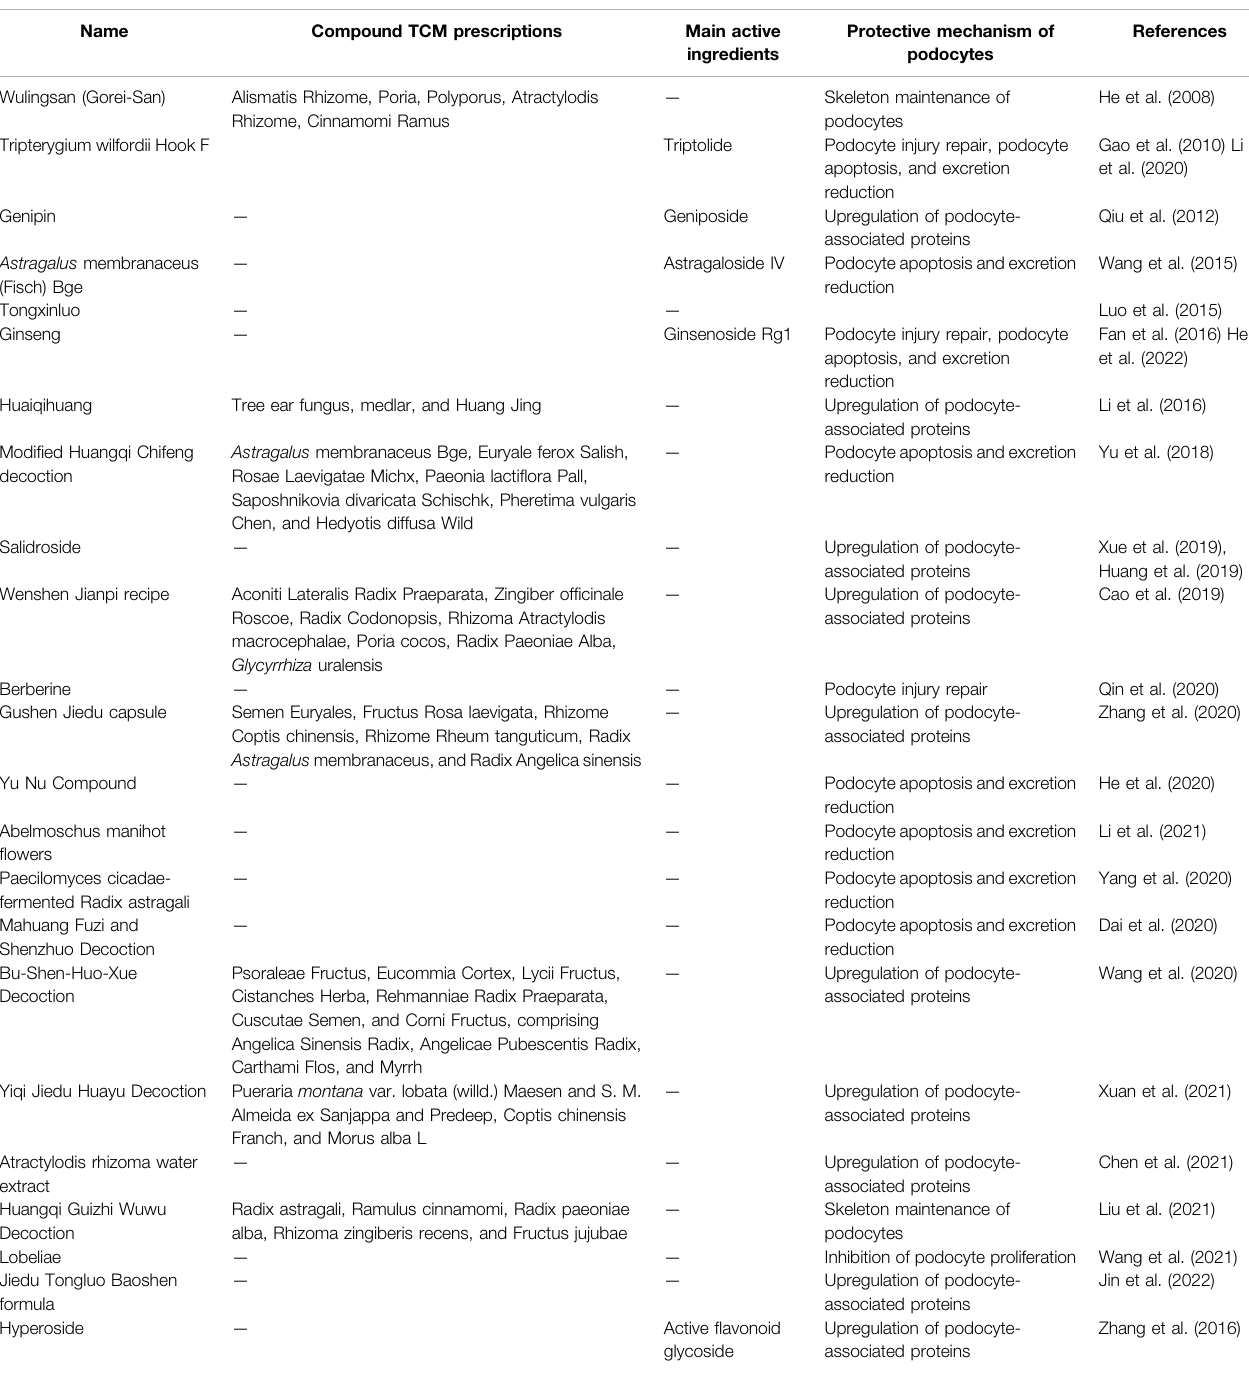
TABLE 1 | Protective mechanism of TCM on podocyte